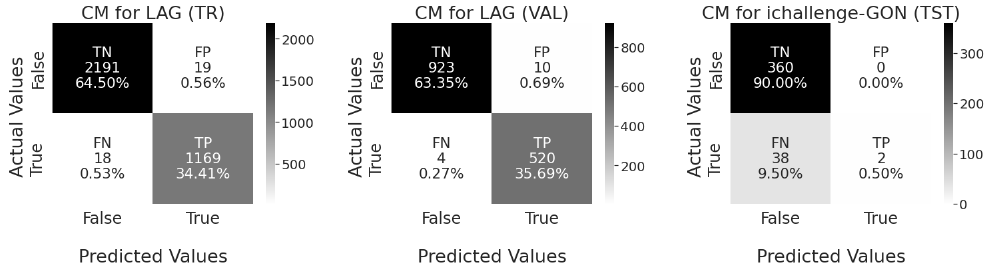
Figure 5. Confusion matrix of Squeezenet trained parameters for GON.